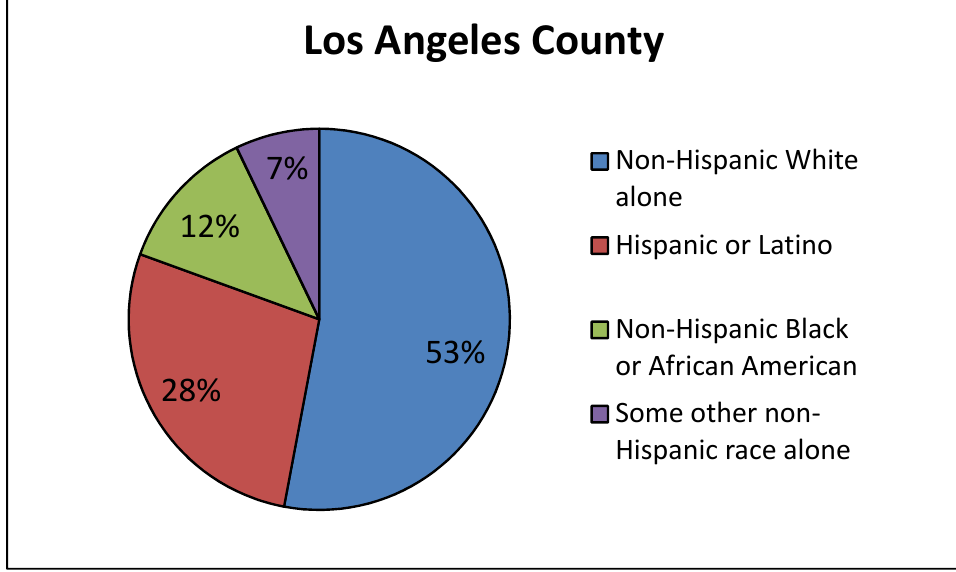
Figure 7. Demographics of the population in Los Angeles County, 1980 Census